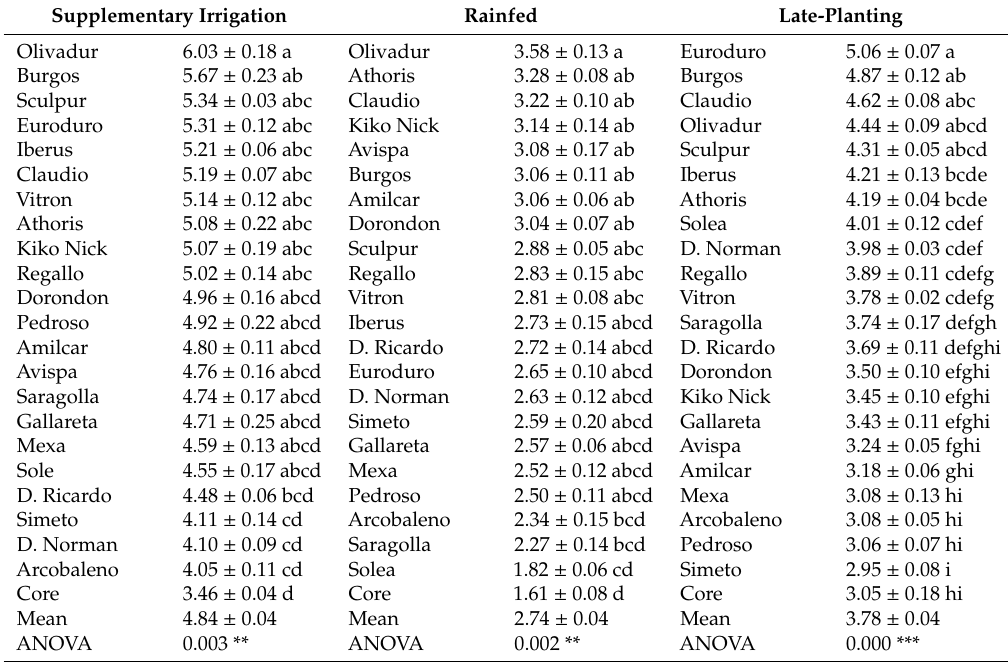
Table 5. Grain yield (Mg / ha) of the set of modern (semi dwarf) durum wheat cultivars across the imposed growing conditions. Cultivars are ordered from the highest-yielding to the lowest. Values are mean ± standard error of three replicates per cultivar. Di ff erent letters (a, b, c, d) indicate significant di ff erences between cultivars within each growing condition according to Fisher’s LSD test. Significance levels of the ANOVAs: ** P < 0.01; *** P <